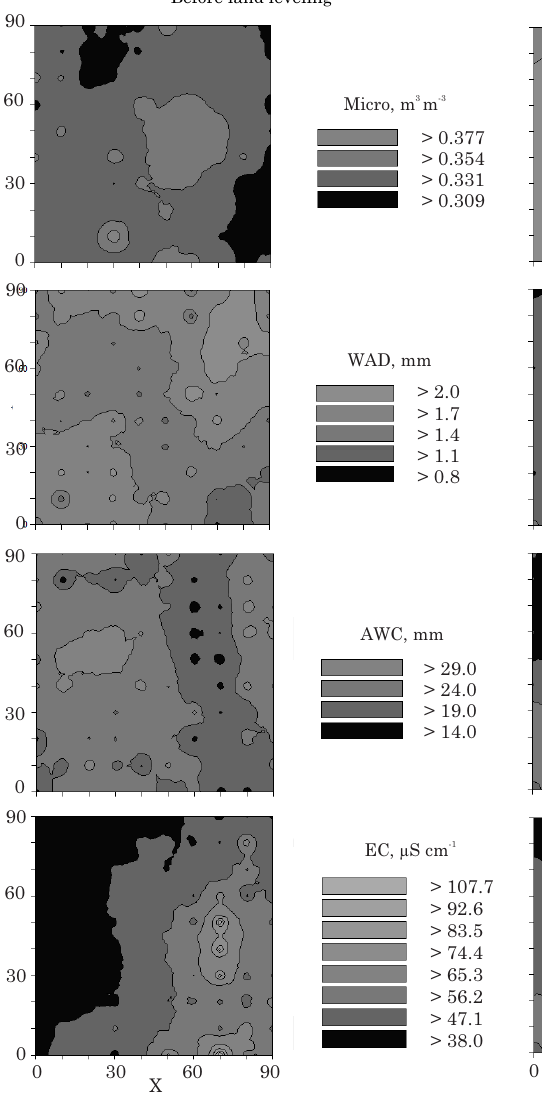
Figure 4. Maps of the spatial distribution of microporosity (micro), weighted average diameter (WAD), available water capacity (AWC), and electrical conductivity (EC) before and after land